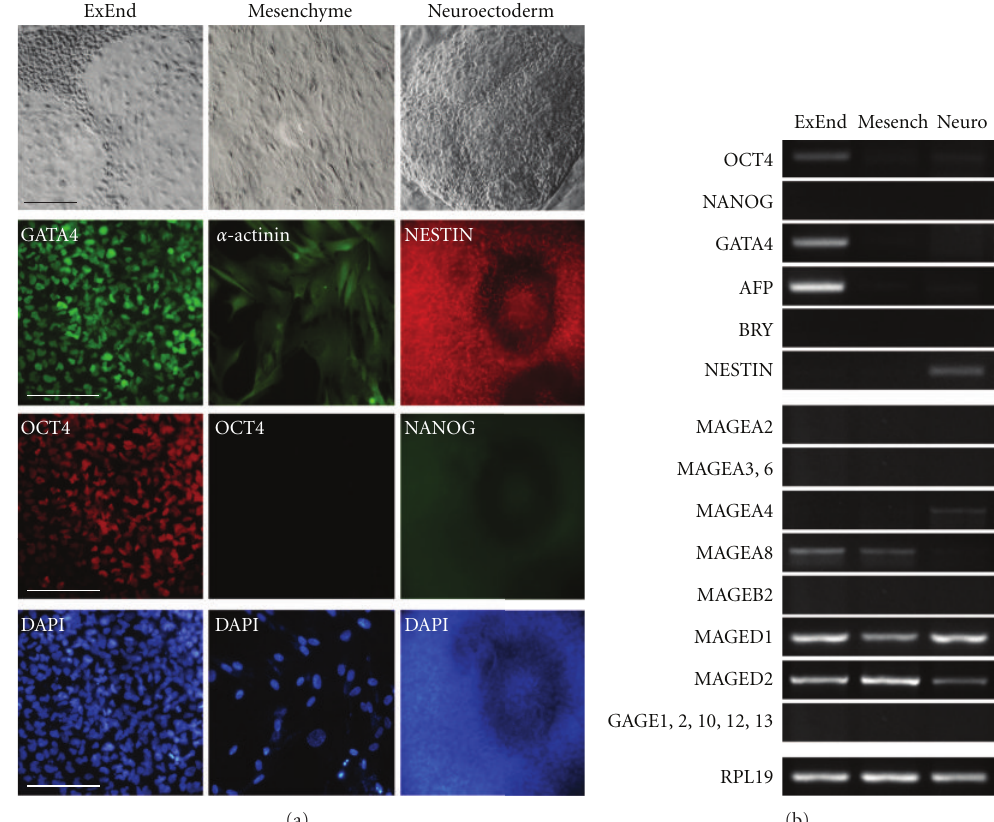
Figure 3: Expression of CTAs and lineage-specific genes in di ff erentiated hES cell derivatives. (a) Morphology and immunostaining of extraembryonic endoderm derivatives by antibodies against GATA4 and OCT4, mesenchymal cells against α -ACTININ and OCT4, neuroectodermal cells against NESTIN and NANOG. Scale bar = 100 μ m. (b) Expression profiles of CTAs and lineage marker genes in hES cell